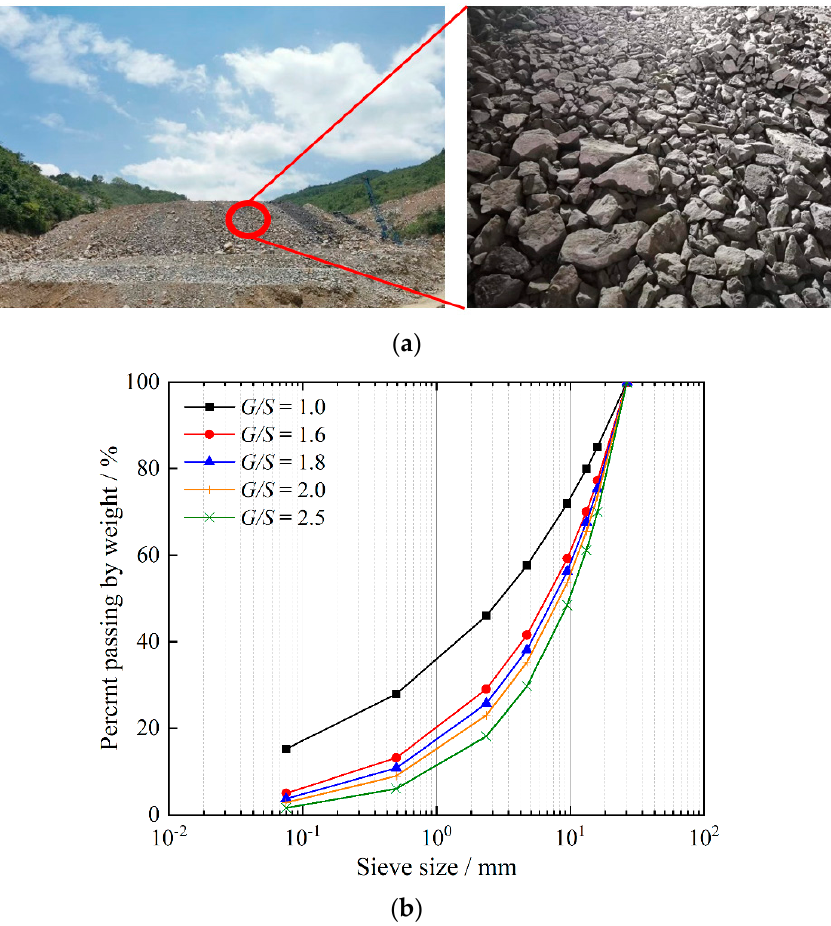
Figure 1. Illustration of ( a ) TRW-derived unbound aggregate materials and ( b ) gradation curves tested in the laboratory.